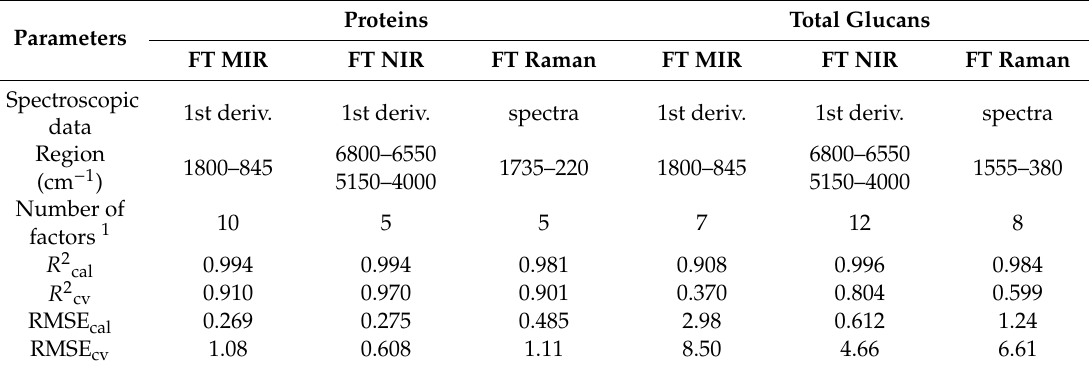
Table 6. Parameters of the partial least squares regression (PLSR)